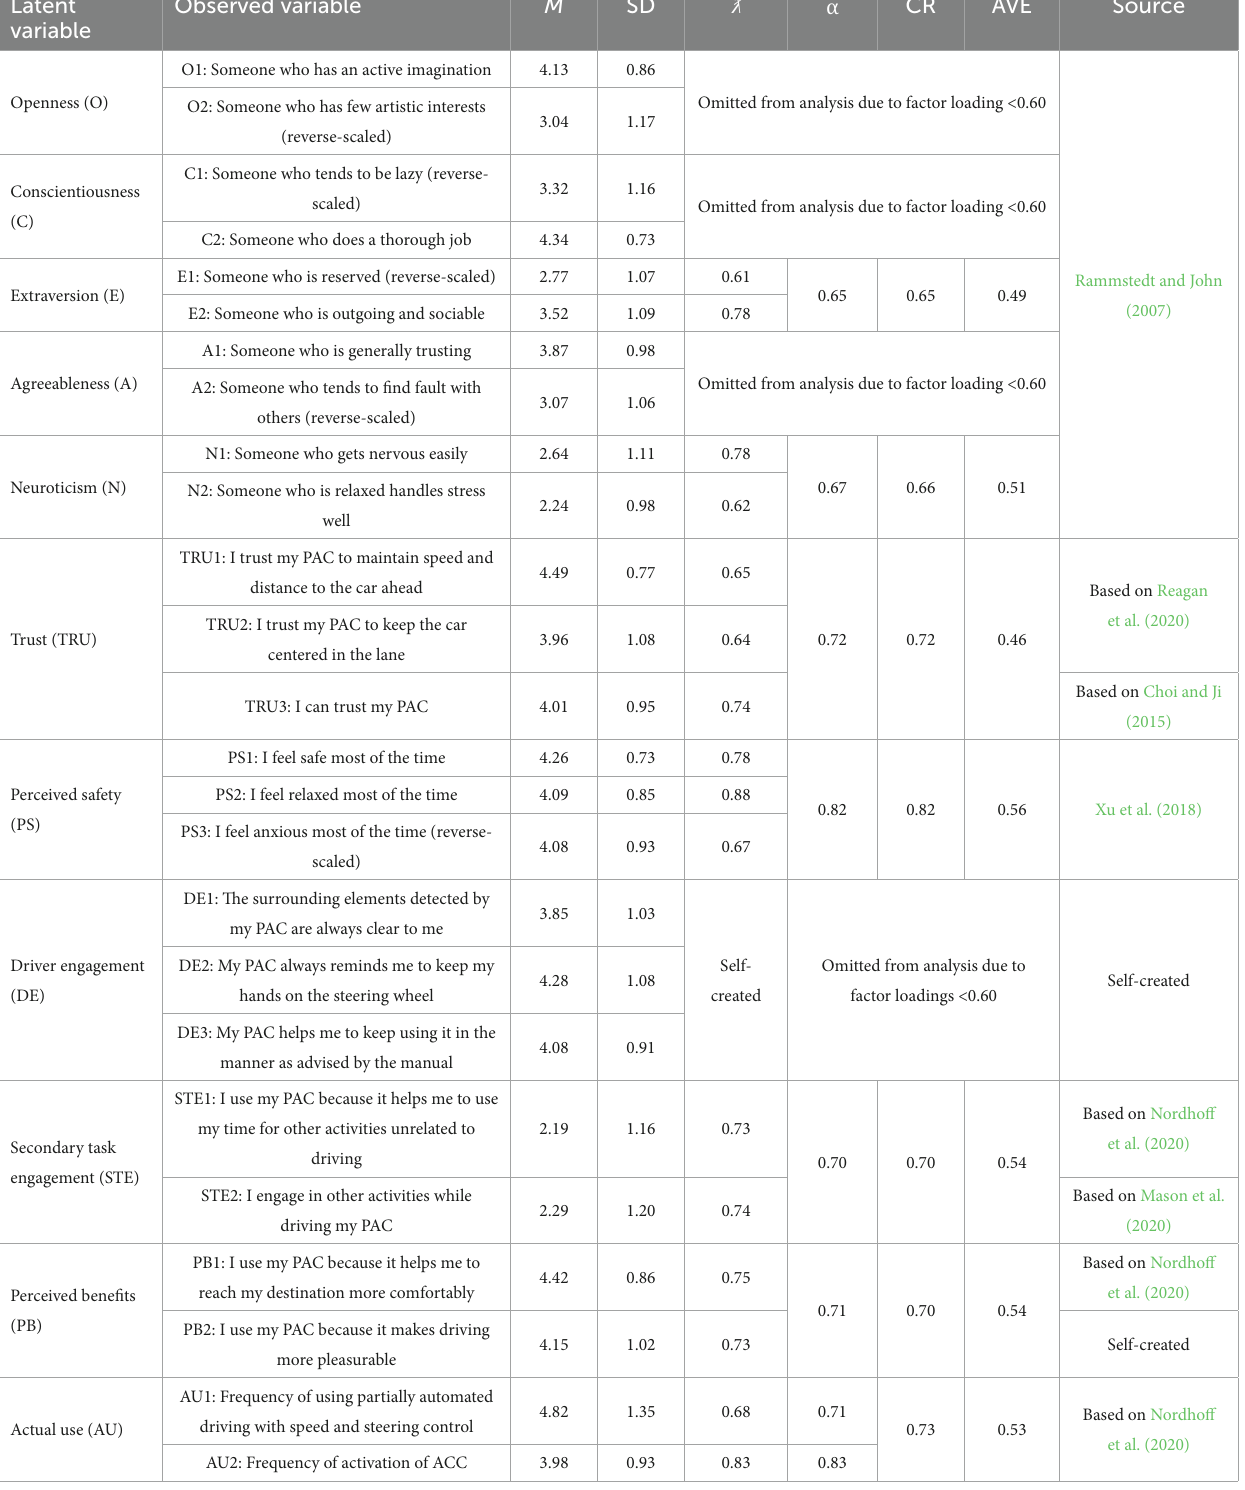
, Cronbach’s alpha, CR, Composite reliability, AVE, Average ⍺